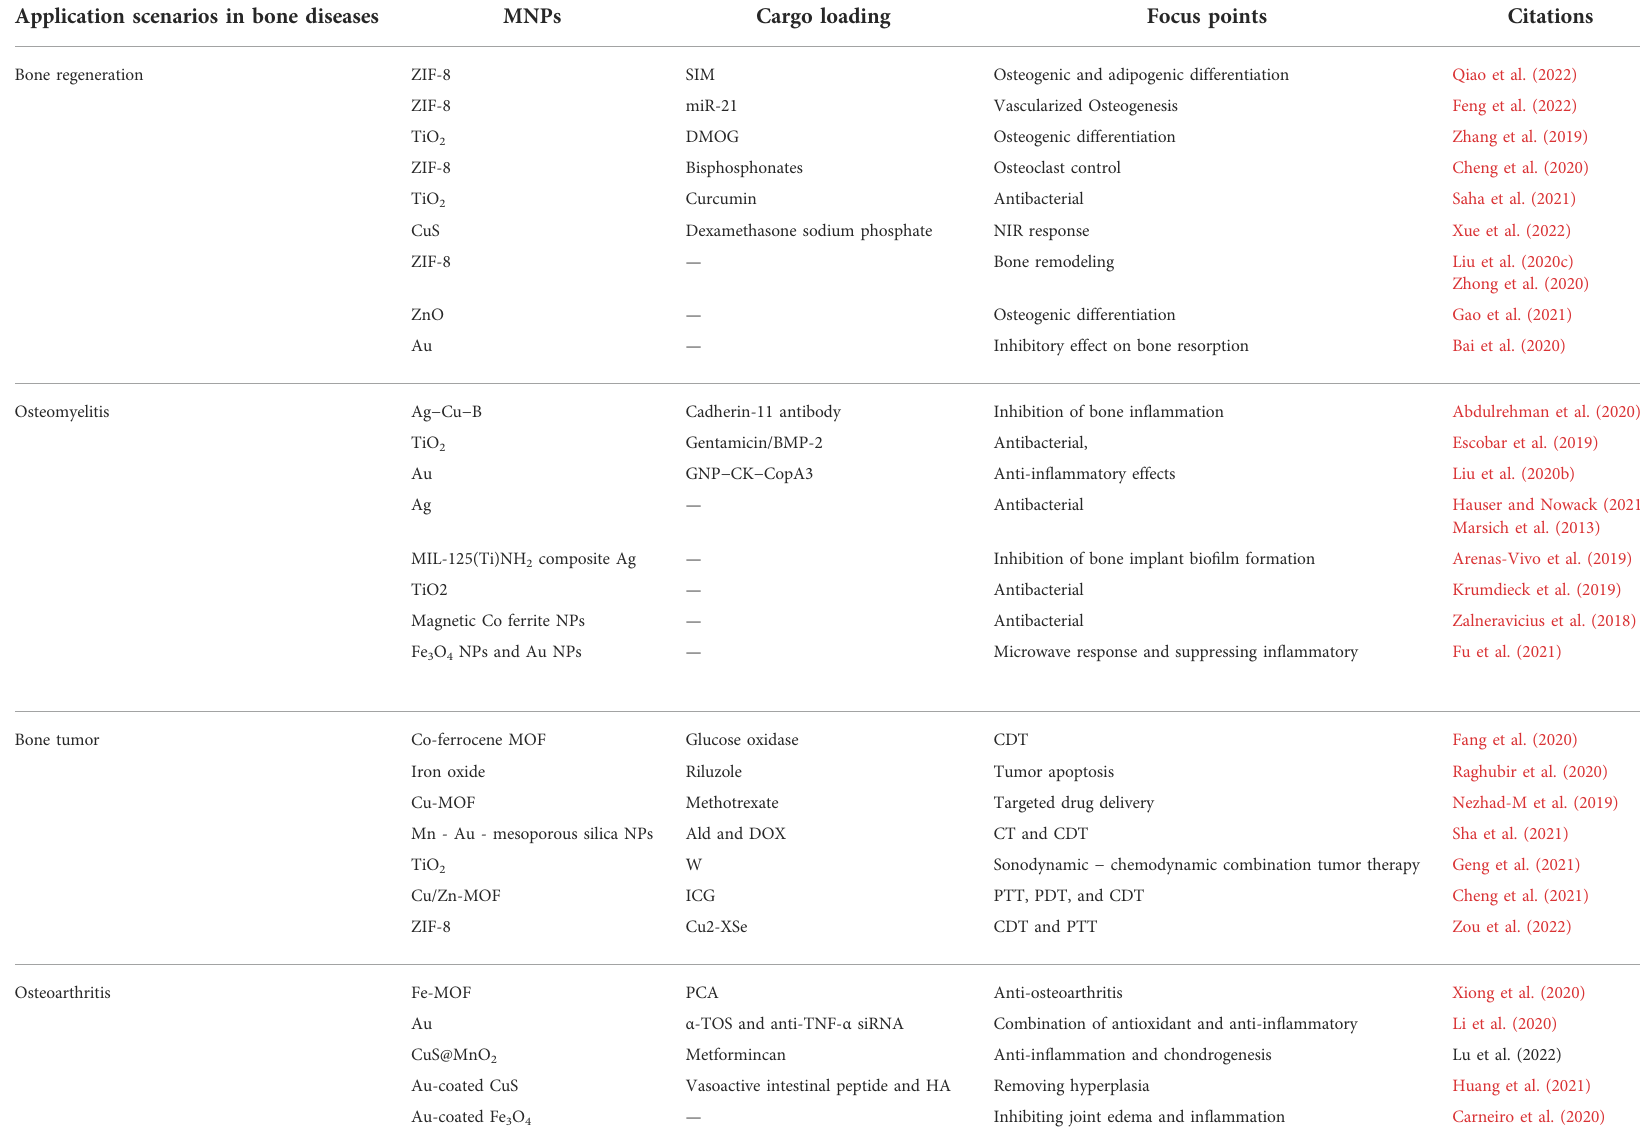
TABLE 3 Application scenarios of MNPs in bone